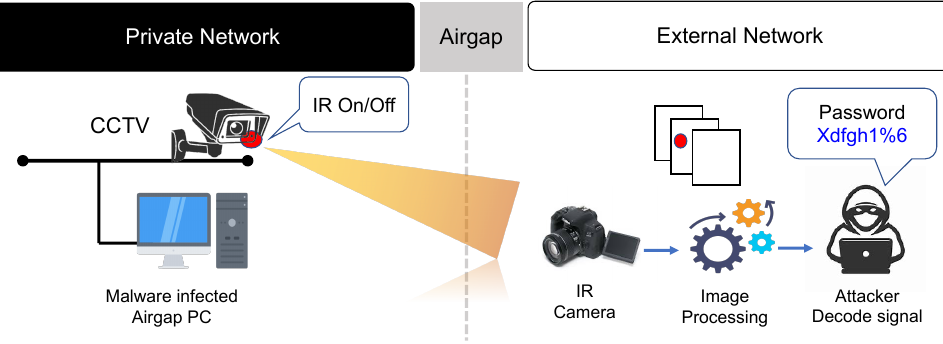
Figure 10. Data leak configuration over the air-gap using